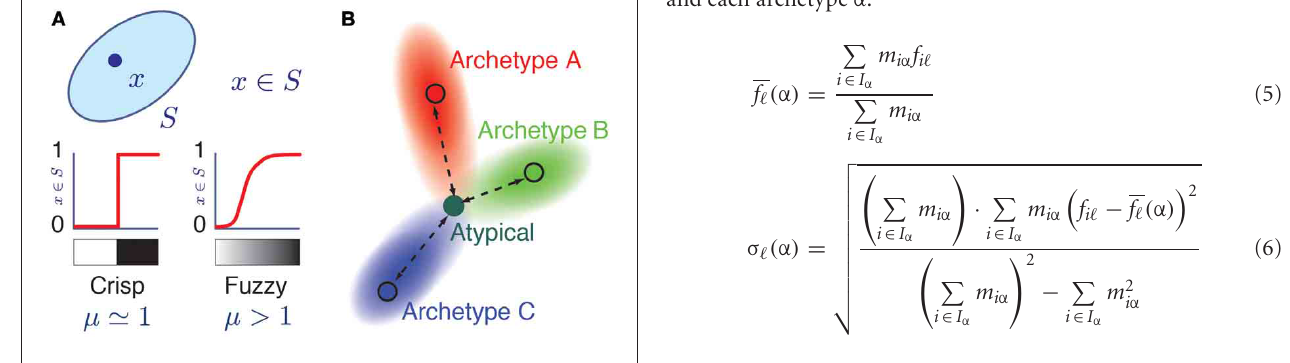
FIGURE 1 | Fuzzy membership to a class. (A) Grayscale representation of the membership relation x = S in ordinary (left) and fuzzy (right) set theories. Here, μ is a fuzziness parameter. When μ = 1, membership relations are crisp as in ordinary set theory, while for μ > 1, membership is a soft relation. The two possible values of a crisp membership are represented by white ( m S ( x ) = 0, x does not belong to S) and black nuances ( m S ( x ) = 1). The graded membership in fuzzy sets (0 < m S ( x ) < 1) is represented by a grayscale gradient. (B) Color coded representation of an atypical cell having memberships with different archetypes. Its hue corresponds to a triple membership between archetypes A (Red), B (Green), and C (Blue) archetypes in the RGB color